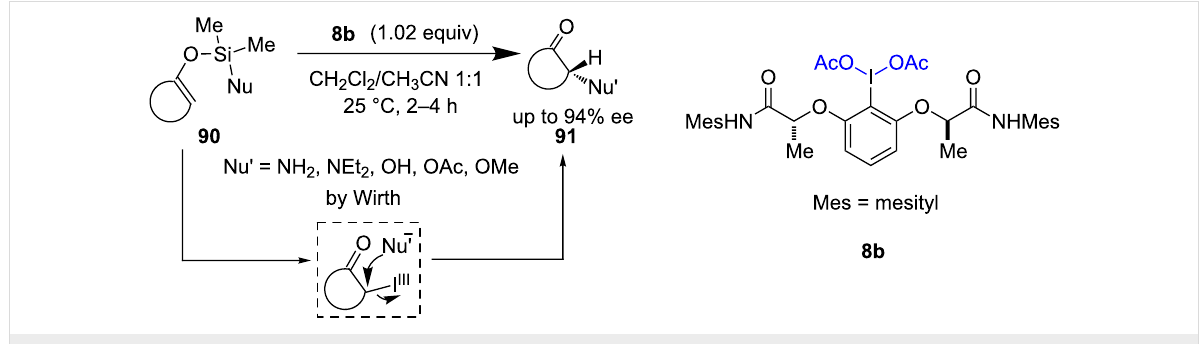
Scheme 19: Asymmetric α -oxygenation and α -amination of carbonyls reported by Wirth et al.